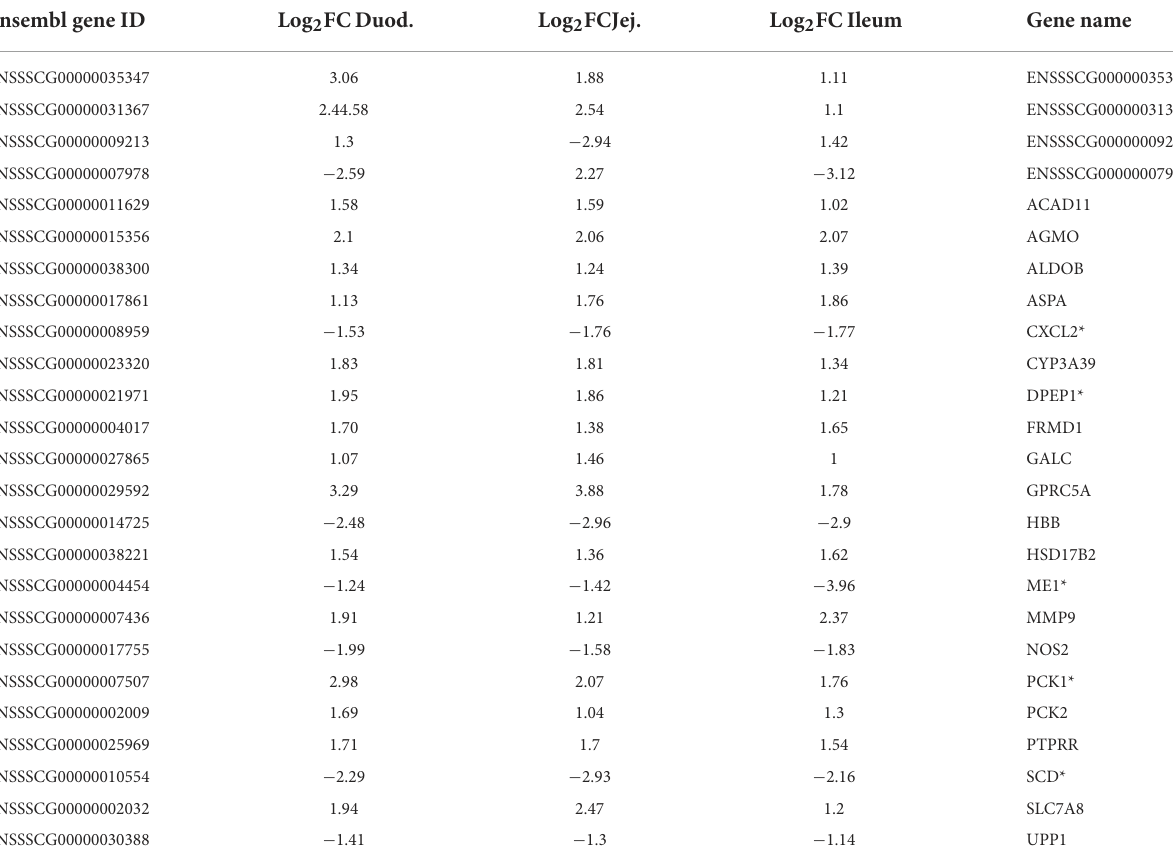
TABLE 1 DE genes in common to all small intestinal sections between the FF and Mal groups. Ensembl gene ID